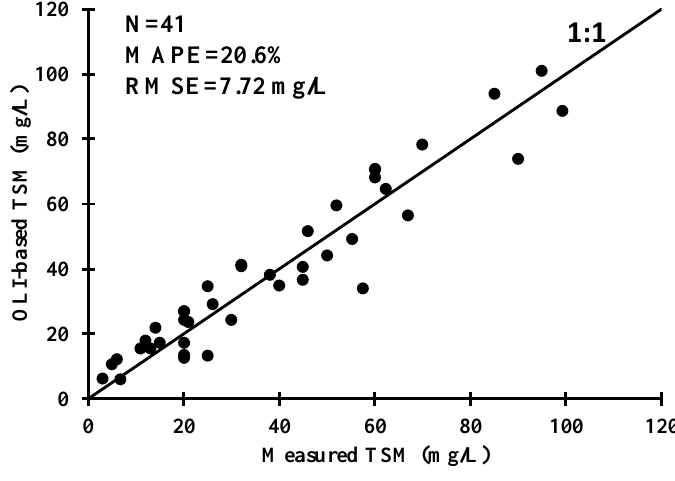
Figure 3. Comparison of measured TSM and OLI-based TSM for Landsat